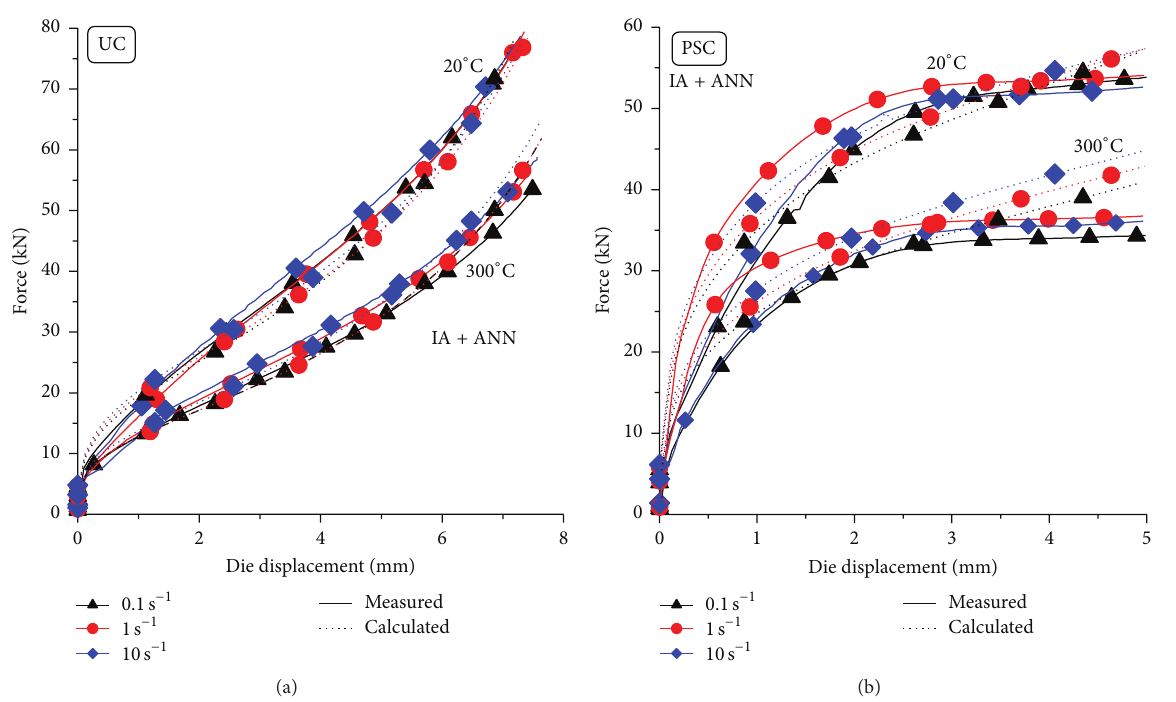
Figure 21: Comparison of forces measured in the uniaxial compression (a) and plane strain compression (b) and calculated by the FE code with (1) with the coefficients obtained from the inverse analysis with the metamodel for both UC and PSC tests (row 1 in Table 9).